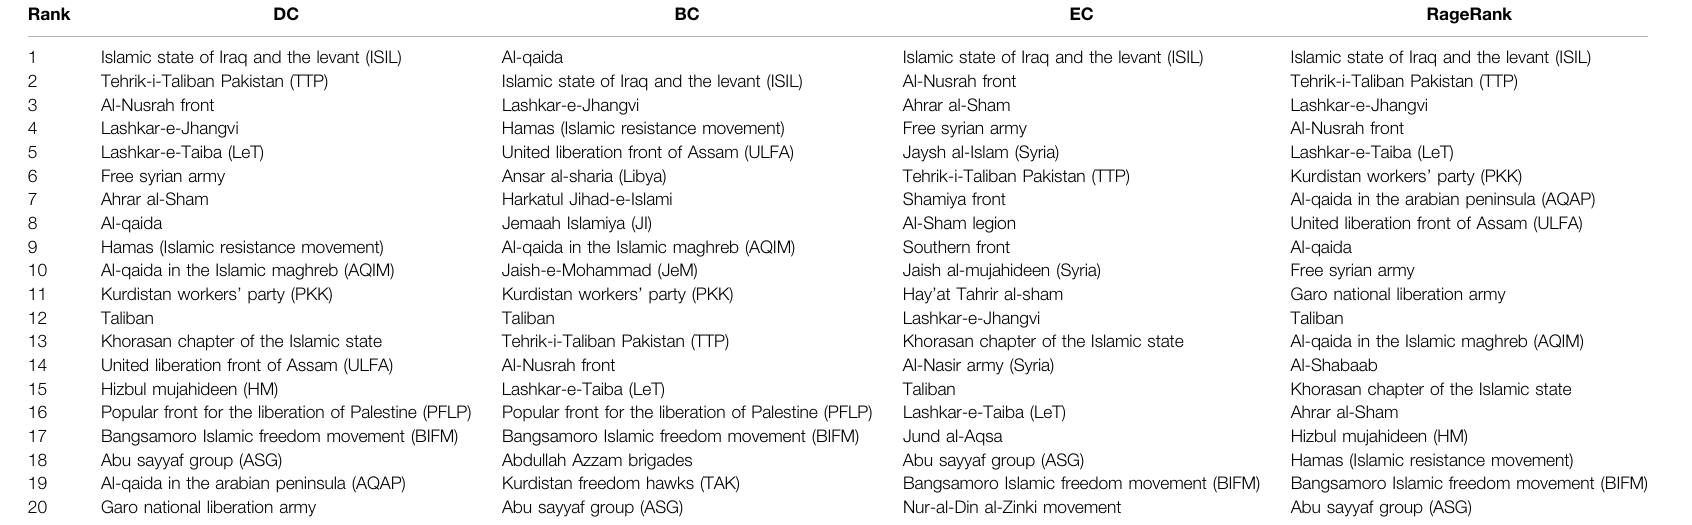
TABLE 2 | The top-20 ranked Terrorist Organizations base on degree centrality (DC), betweenness centrality (BC), eigenvector centrality (EC), and PageRank (PR) in TOA